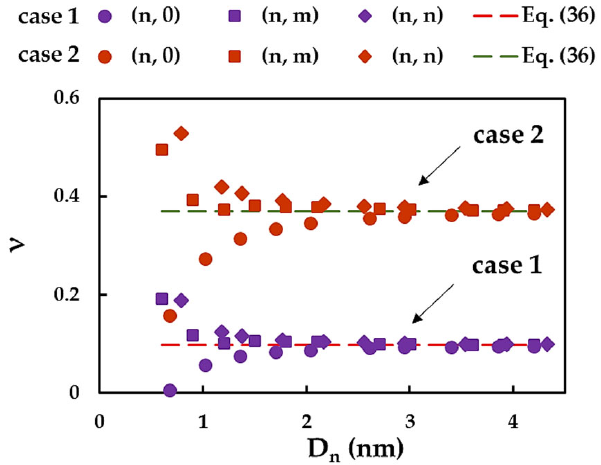
Figure 14. Evolutions of the Poisson’s ratio,  , as a function of the NT diameter, D